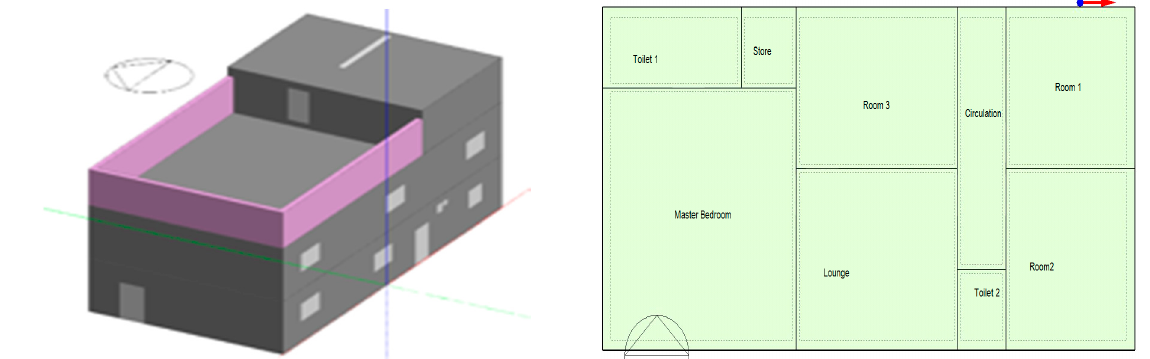
Figure 7. The plan and geometric description of Villa. Energies 2018 , 11 , x FOR PEER REVIEW